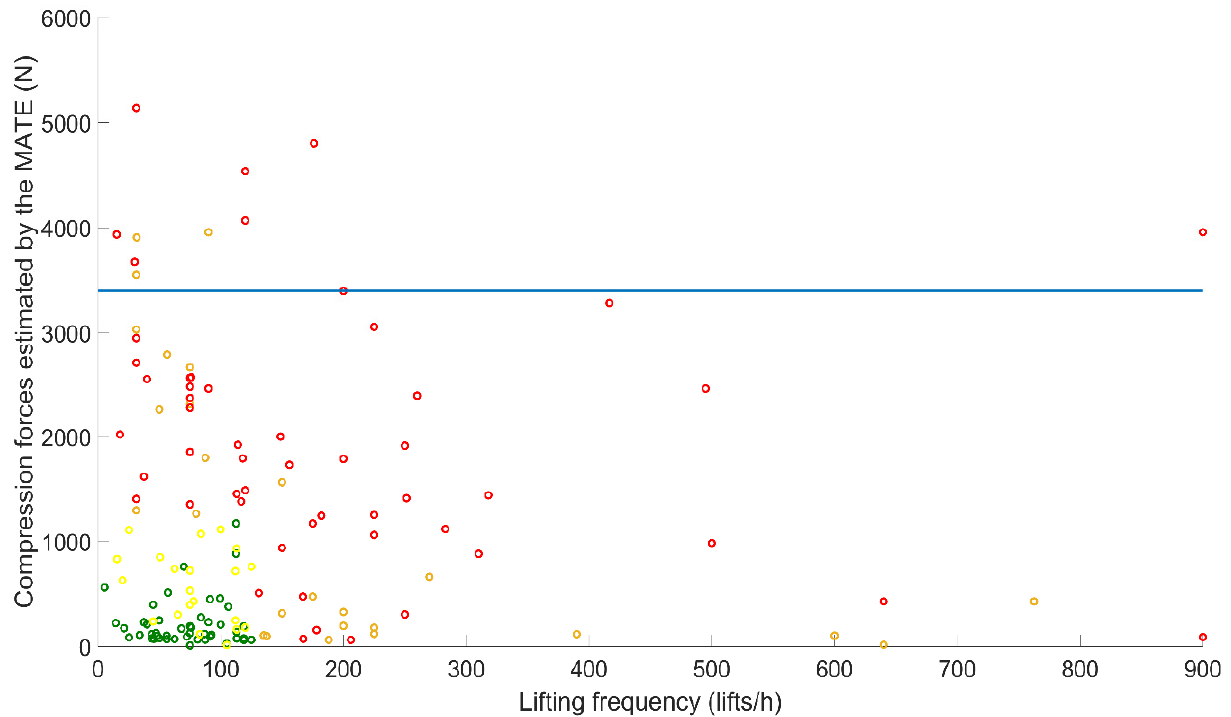
Figure A2. The 148 material-handling tasks described by Zurada et al. [30] are shown by lifting frequency and estimated compression forces at L5 calculated using the musculoskeletal-modeling workflow incorporated in the MATE. The blue line identifies the 3400 N compression NIOSH limit, green dots indicate a task that is defined as a low-risk task in the validation dataset and identified as a low-risk task by the MATE, orange dots indicate a task that is defined as a low-risk task in the validation dataset and identified as a high-risk task by the MATE, red dots indicate a task that is defined as a high-risk task in the validation dataset and identified as a high-risk task by the MATE, and yellow dots indicate a task that is defined as a high-risk task in the validation dataset and identified as a low-risk task by the MATE.